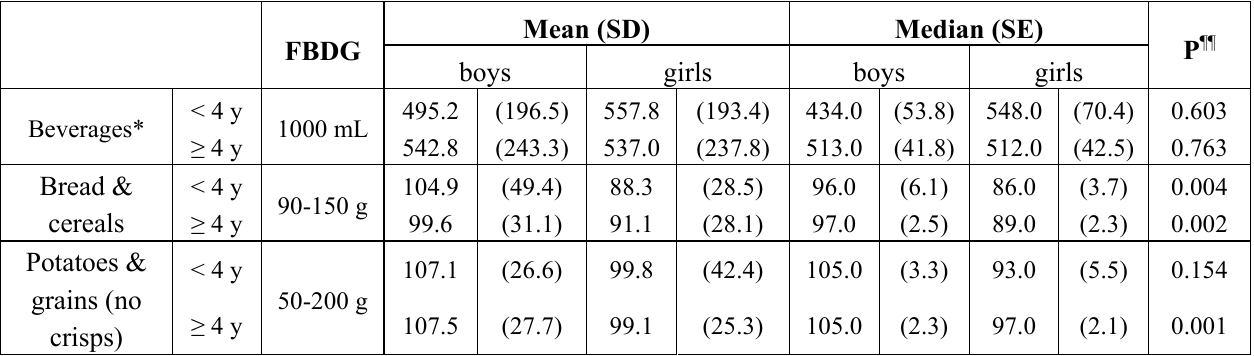
Table 1. Food intake calculated from estimated diet records, with adjustment for